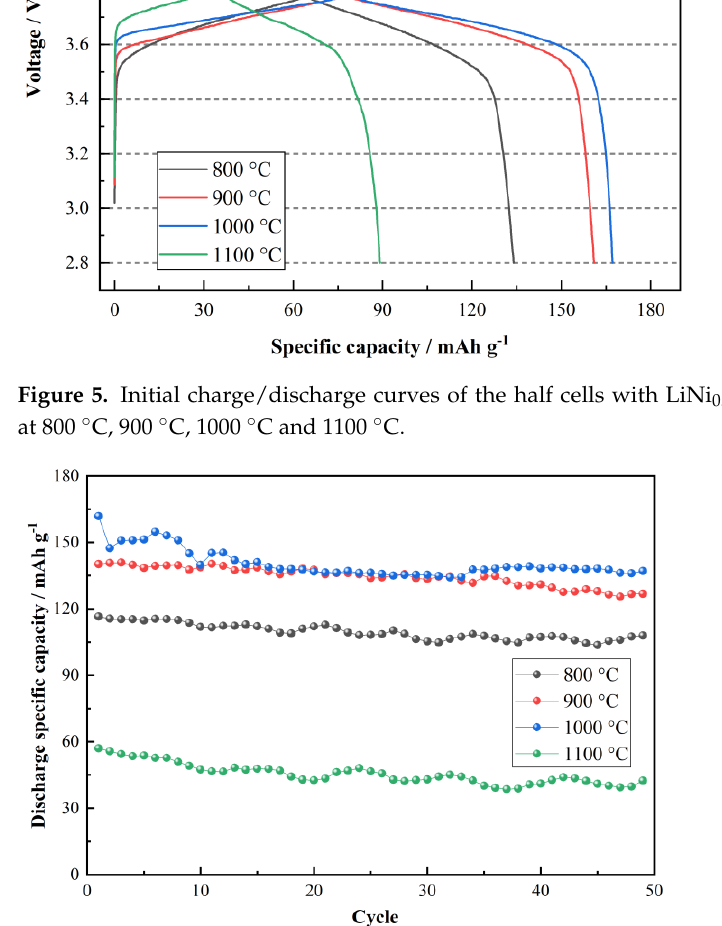
Figure 6. Cycling property of the half cells with LiNi 0.5 Co 0.2 Mn 0.3 O 2 synthesized at 800 °C, 900 °C, 1000 °C and 1100 °C.